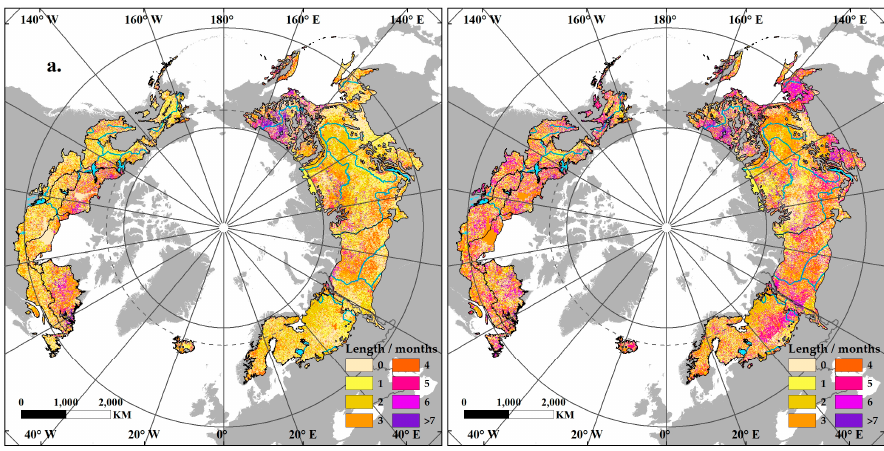
Figure 6. The spatial pattern of the length of different preseason: ( a ) the maximum temperature (TMAX) preseason; ( b ) the minimum temperature (TMIN) preseason.